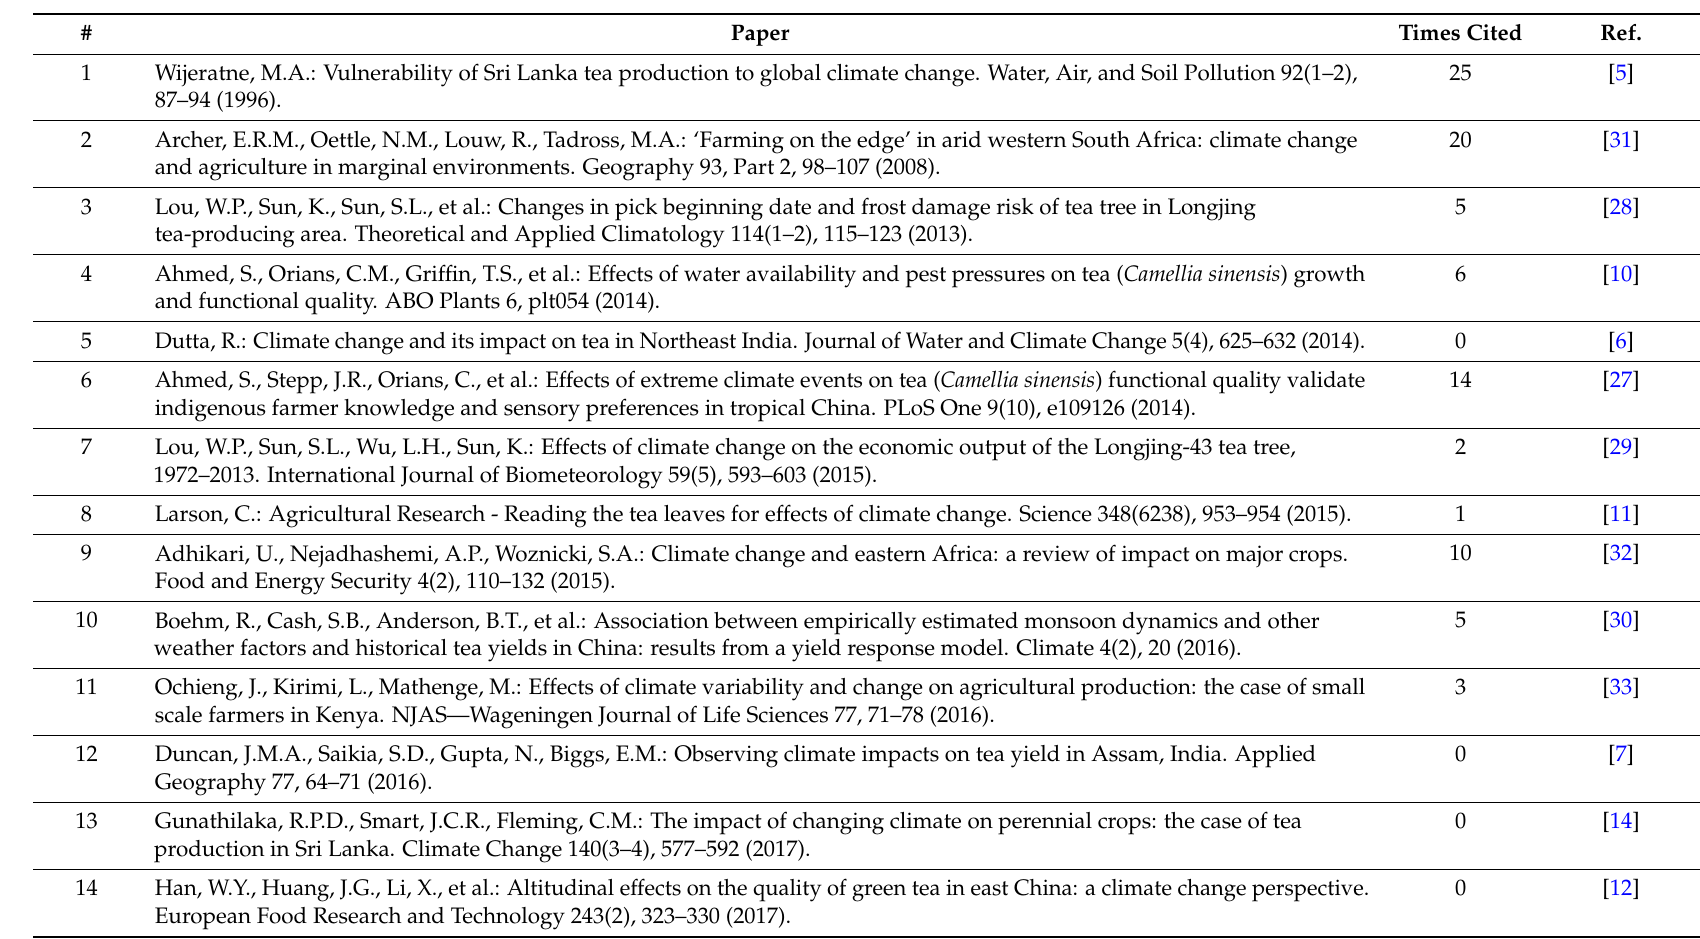
Table 1. List of 14 key papers dealing with climate change and tea production including the number of citations (times cited) until present (source: WoS, date of search: 1 June 2017). The papers are sorted by publication years in ascending order. Paper Times Cited